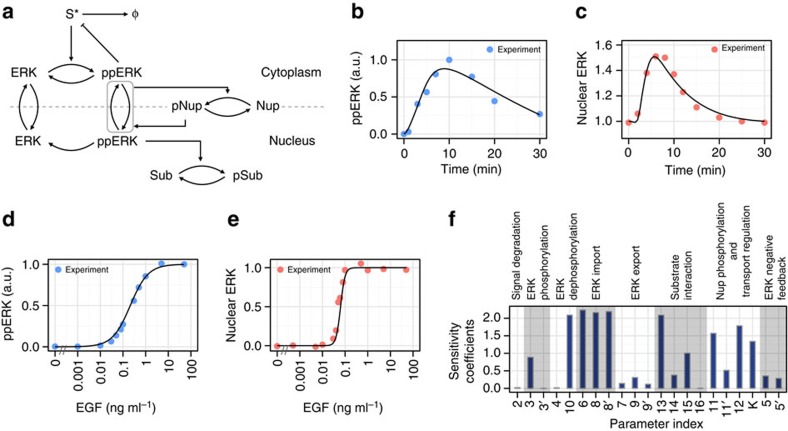
Mathematical modelling of ERK phosphorylation and nuclear translocation.(a) Topology scheme of the model. (b) Time courses of ppERK and (c) nuclear ERK in response to EGF (50 ng ml−1) stimulation were numerically simulated with the model (solid lines). Points represent experimental data. (d) Dose–response relation of EGF and ppERK or (e) nuclear ERK. Points and solid lines indicate experimental and simulation data, respectively. (f) Sensitivity analysis for the Hill coefficient of ERK nuclear translocation response. Sensitivity coefficients were calculated by making 1% changes in parameters and absolute values are shown.